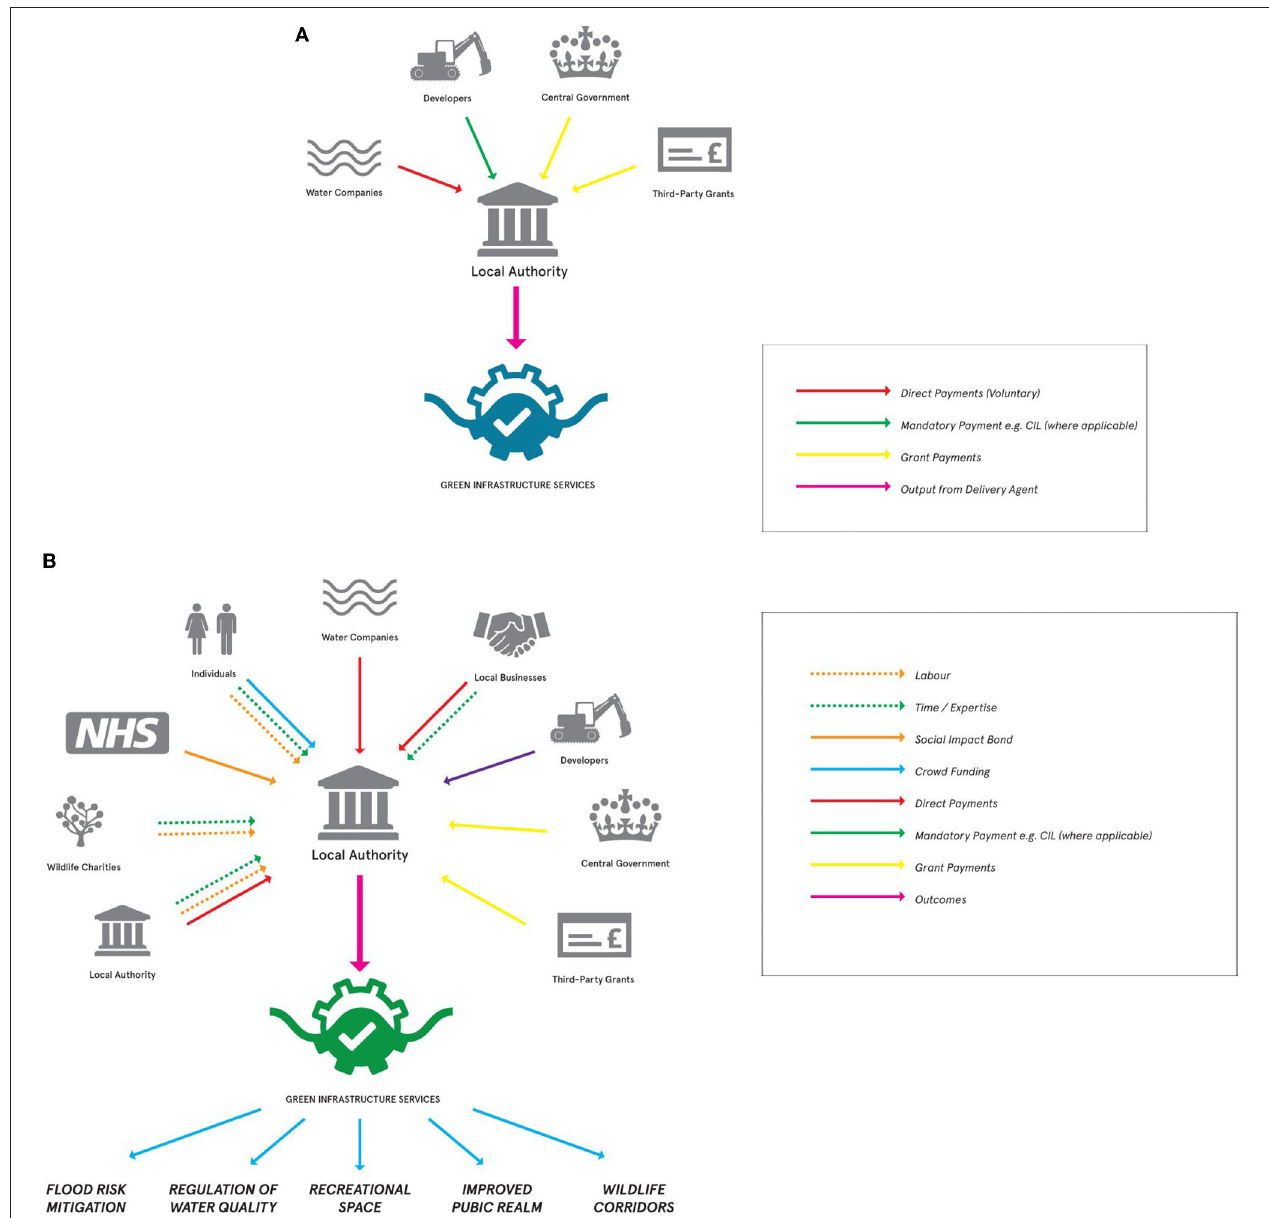
who or what the benefit is for, the type of value, and where (X) and when (T) the value is captured, plotted on orthogonal axes. The map shows that spatially, green infrastructure can offer flood protection to both the same set of stakeholders (those in the immediate vicinity and on neighboring sites, including the mainline rail station in the case of the Newcastle Helix site), and a wider set of stakeholders than the piped solution. The additional values created by the green infrastructure that are not created by the traditional piped solution include local pride for individuals and the Local Authority due to the increased amenity and aesthetic value of the green infrastructure, i.e., for more than